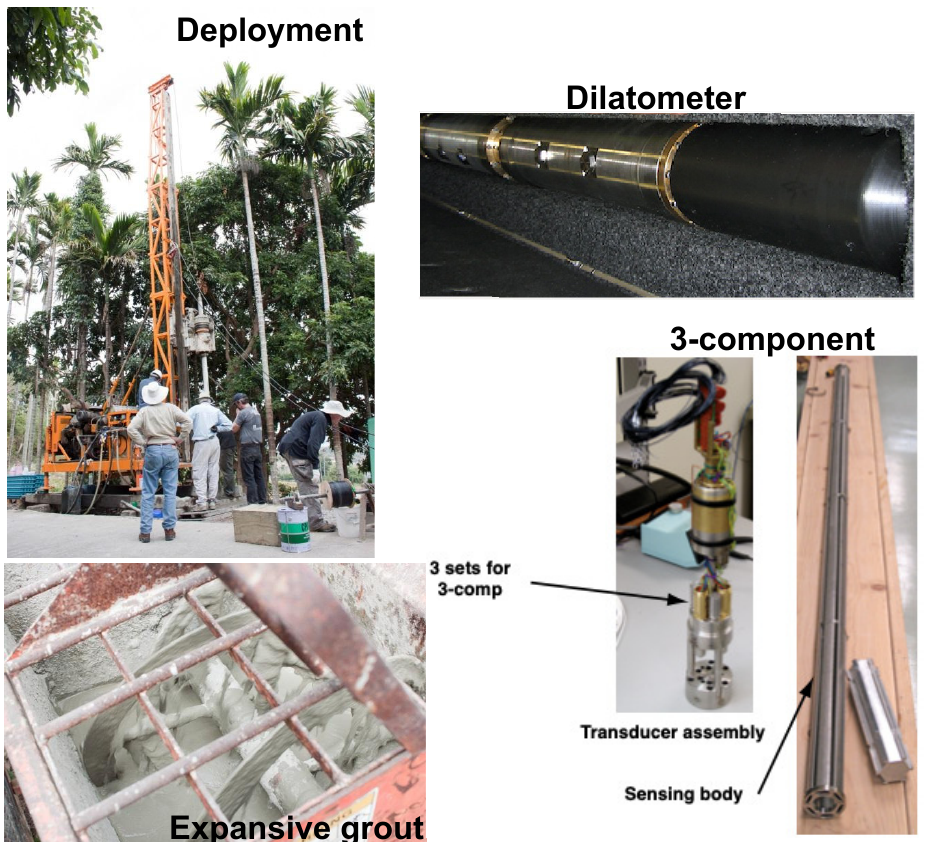
Figure 4. Photos of sensor designs and their deployment in the LV. During the following years after its installation in the borehole, the sensor is affected by transient effects due to curing of the expansive grout and viscoelastic stress relaxation around the newly drilled borehole [24]. They induce exponential trends on the strain records, yet relatively easy to predict and correct (Figure 5).